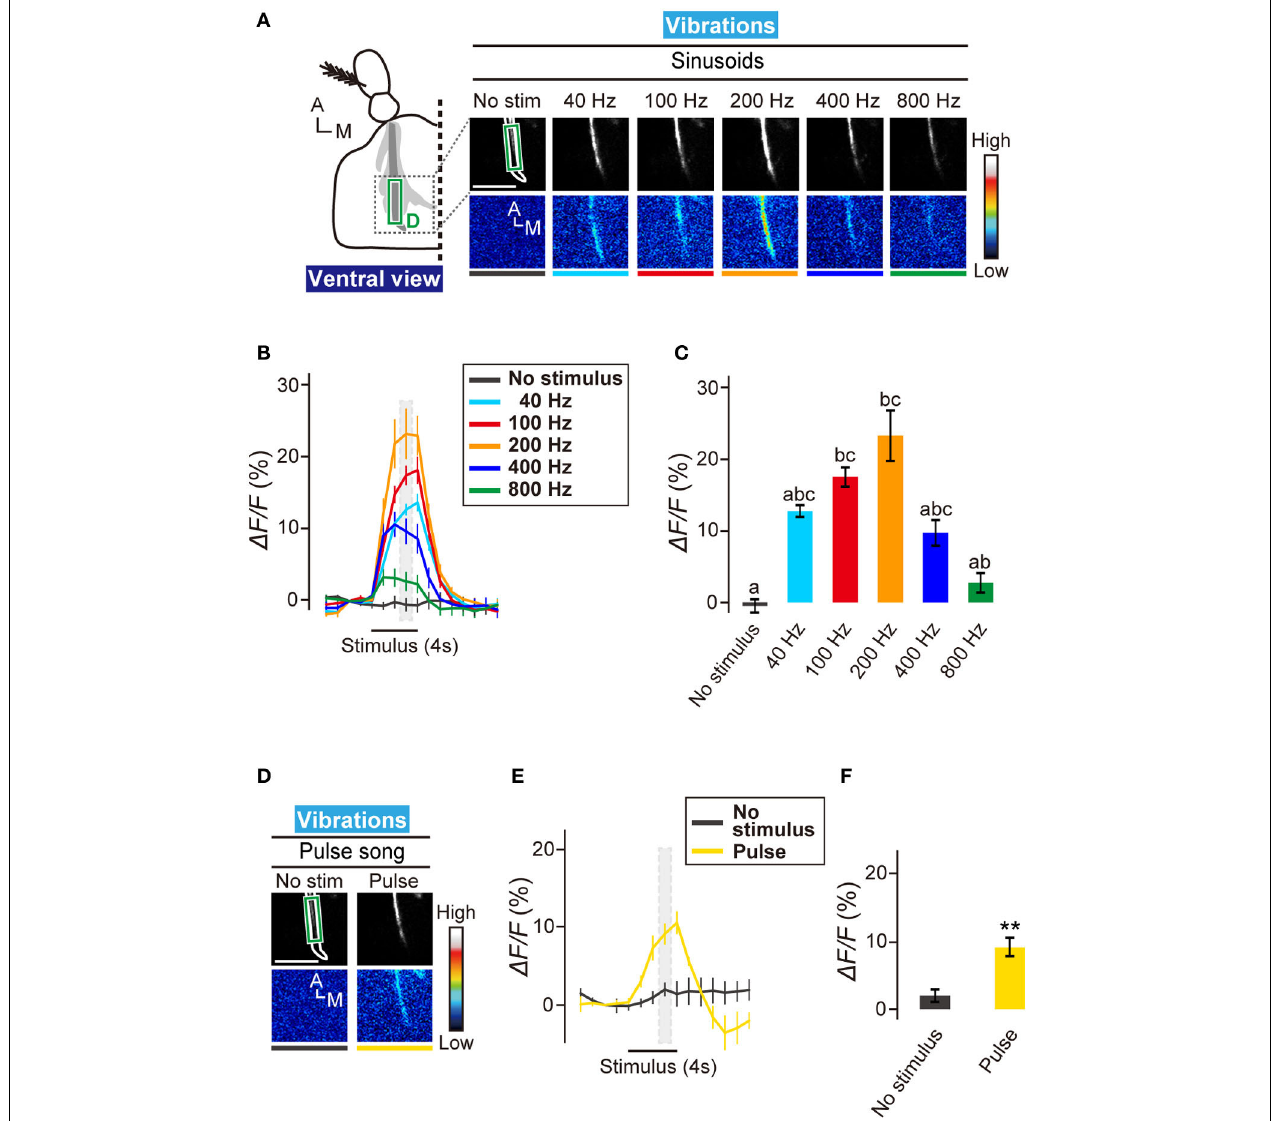
FIGURE 3 | Neural activity of subgroup-D JO neurons to vibrations. (A) Calcium response in AMMC zone D to sinusoidal vibrations at 40, 100, 200, 400, and 800Hz. The region of interests (green box) for calculating changes in fluorescent intensities shown in panels (B,C) was set on the main output sites of zone D. Scale bar = 25 µ m. (B) Time trace of calcium responses to sinusoidal vibrations in zone D (green box in panel A ). Gray hatched boxes indicate time-windows for calculating (cid:2) F / F in no-stimulus and during-stimulus periods shown in panel (C) . N = 7 animals. (C) Response